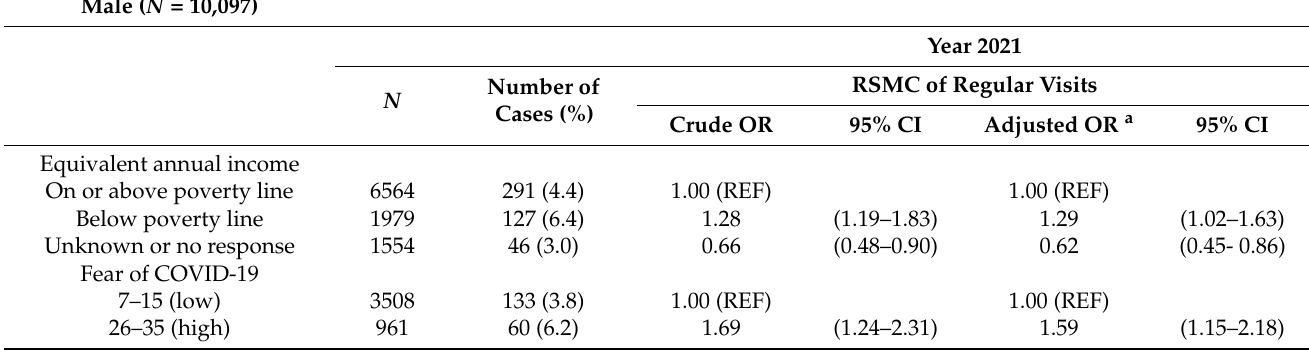
Table 2. Odds ratios (ORs) of household income for refraining from seeking medical care (RSMC) of regular